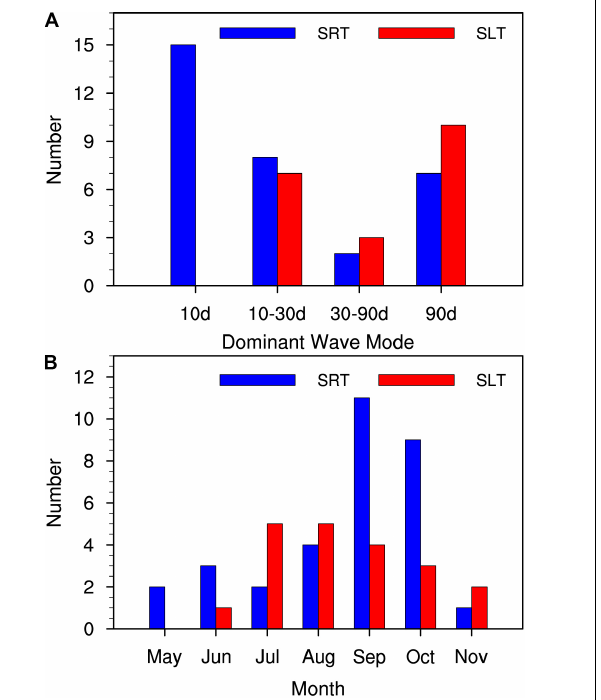
FIGURE 2 | The number of the SRT and SLT cases dominated by the different wave modes (A) and the monthly distribution (B) . Blue and red bars represent the numbers of SRT and SLT,